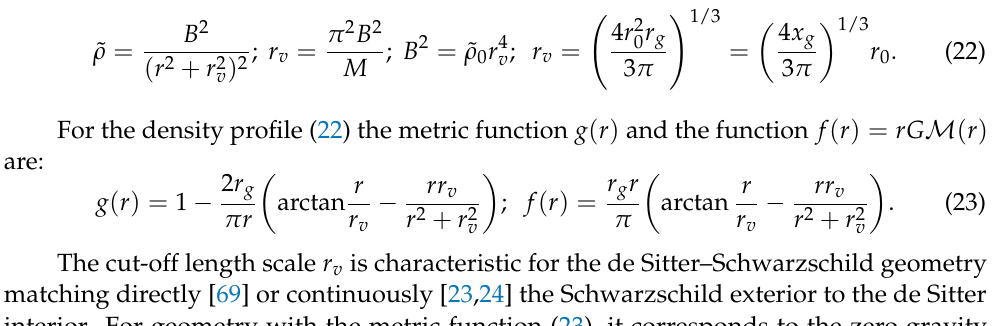
Figure 2. S -surface, horizons and ergospheres for a = 0.314 ( Left ) and a = 0.4 ( Right ). As follows from Equation (15), the height of the S -surface H = | z | max = decreases when x g increases, while the event horizon increases with increasing x g , so that for the case of a black hole S -surface, its located in the ergoregion beyond the internal horizon r − in the interior R -region, which is unavailable for an outside observer. The case of a soliton S -surface is located beyond the ergosphere, its height increases with increasing a , i.e., the phantom region fits within the ergoregion, and the processes of energy extraction involve the phantom energy and are facilitated by the absence of the event